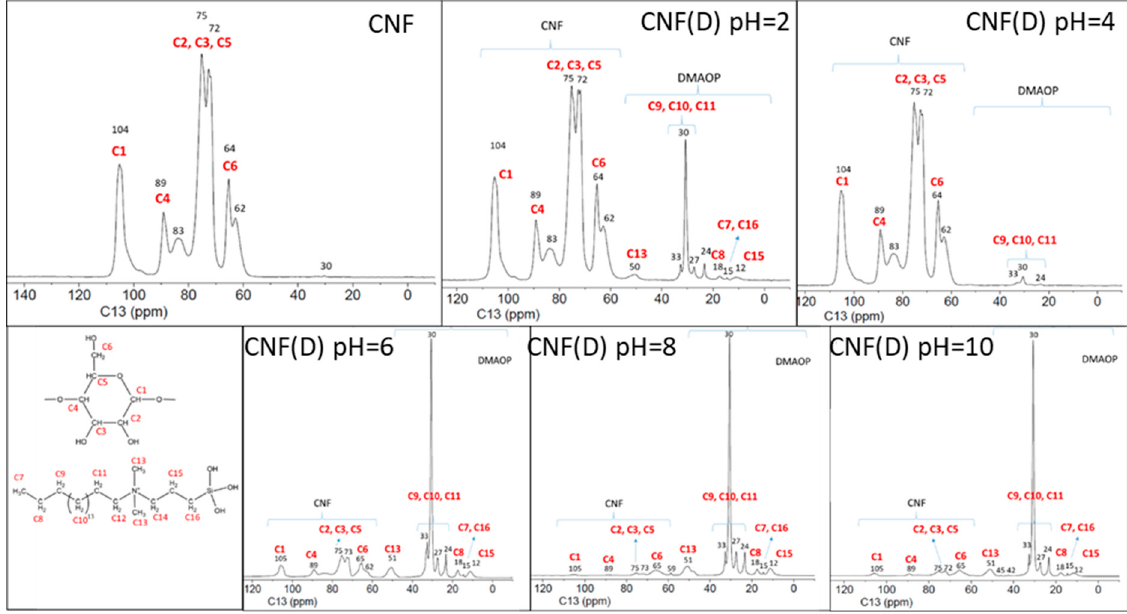
Figure 2. Carbon-13 (C13) nuclear magnetic resonance ( 13 C NMR) spectra of reference CNF and CNF(D) at different pH reaction conditions (2, 4, 6, 8 and 10).